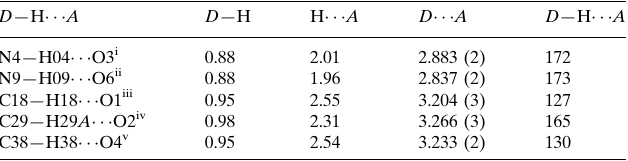
Hydrogen-bond geometry (A˚ , (cid:4)